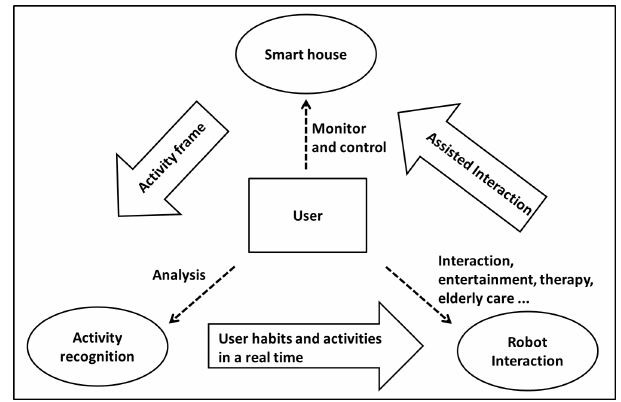
Figure 1: The idea of the system is to connect the three elements (smart house, activity recognition and robot interaction) into a sup- port activity aware system. The smart house information is repre- sented using the activity frame. The activity recognition system is based on decision tree or conditional matrix. The user habits, activi- ties and intention are used by the robot planner. The robot interacts with the user, as an assisted component, and manage the environ- ment (smart